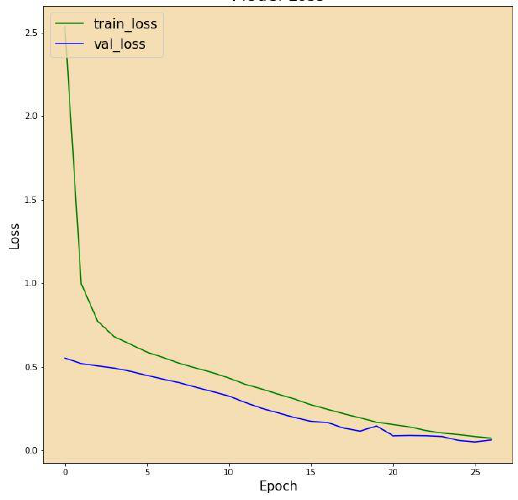
Figure 8. Model loss before using cGAN.